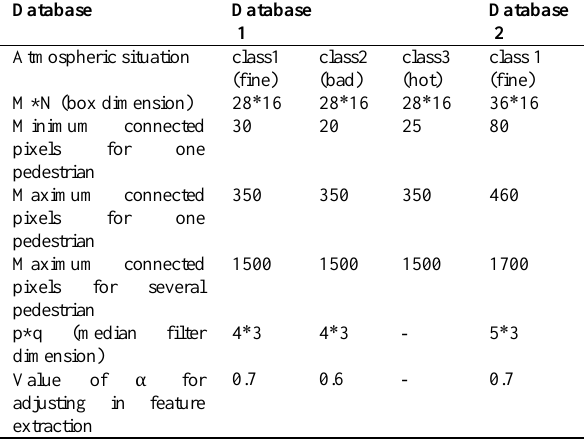
Figure 24. Creating binary image for three samples of pedestrian (A) and non-pedestrian (B) (row 1: samples of pedestrians and non-pedestrians, row 2: adjusting contrast of samples of row 1, row 3: applying median filter, row 4: creating binary image). Table 3. Parameters of proposed method in